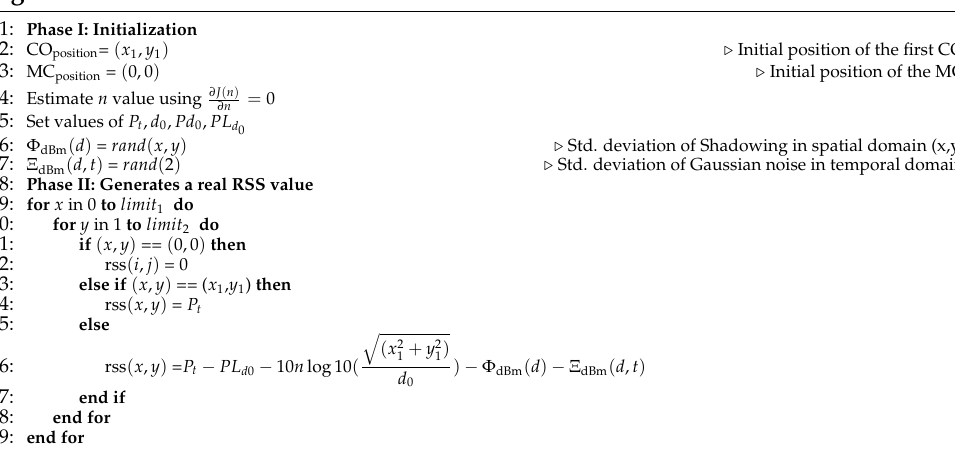
Algorithm 1 Simulation of a realistic RSS